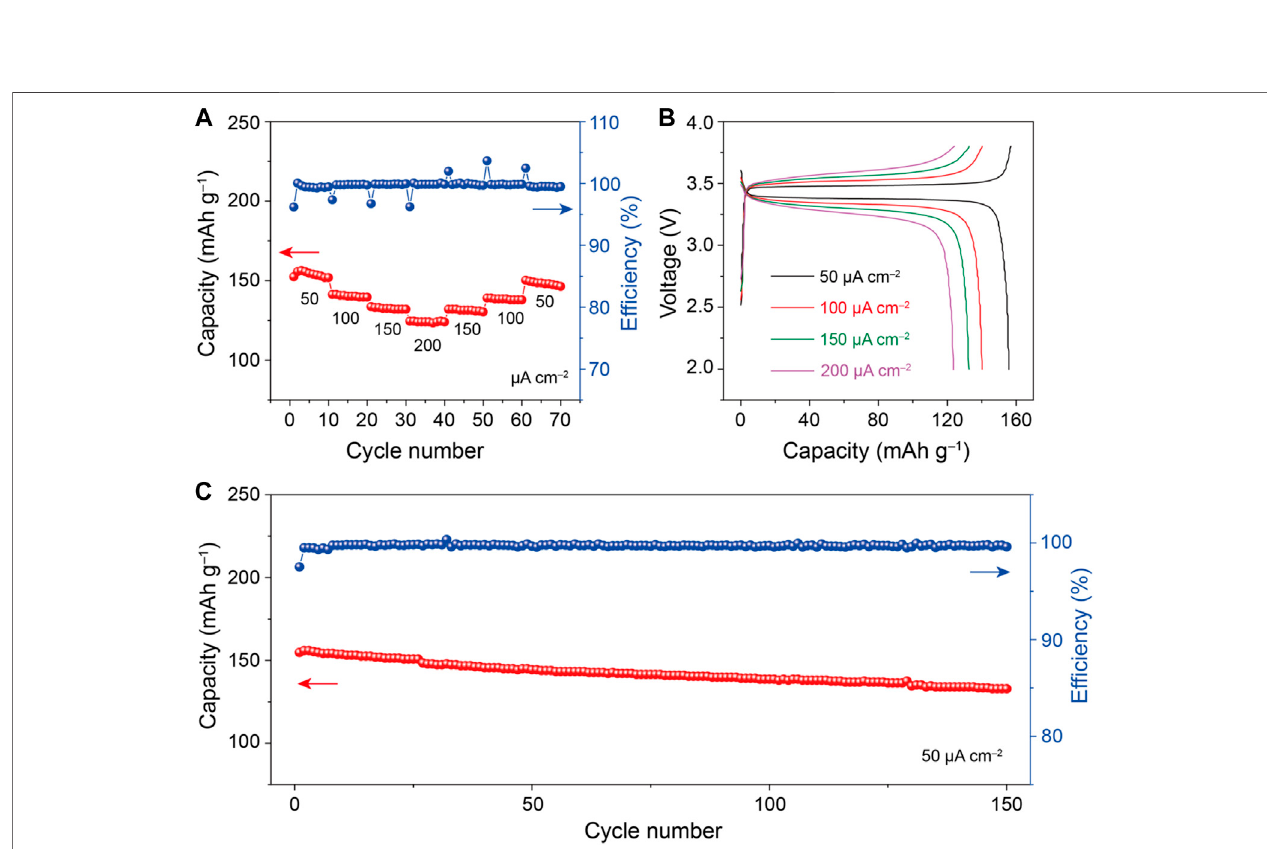
FIGURE 5 | (A) Rate performance, (B) voltage-capacity curves, (C) cycle stability and Coulombic ef fi ciency of the Li/CPE-10/LiFePO